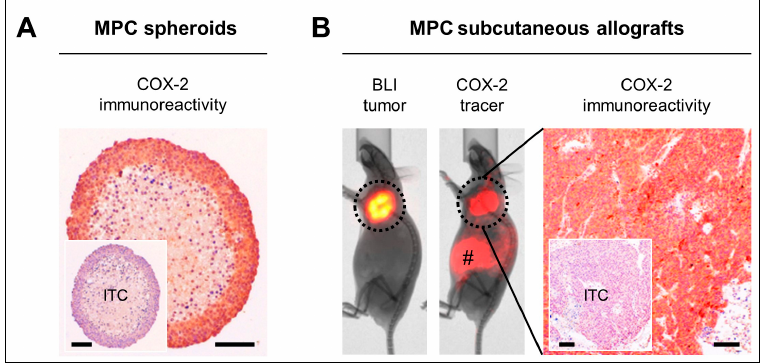
Figure 5. COX-2 as a molecular target in MPC spheroids and allografts harboring a heterozygous Nf1 knockout; ( A ) COX-2 immunoreactivity in MPC spheroids; ( B ) COX-2 functional imaging and immunoreactivity in a luciferase-expressing subcutaneous MPC allograft model; (BLI) bioluminescence imaging of tumors; (COX-2 tracer) tumor uptake of a red-fluorescent COX-2 selective imaging probe; (#) residual non-specific accumulation of COX-2 tracer due to intraperitoneal injection; (ITC) IgG isotype control; scale bars: 0.1 mm